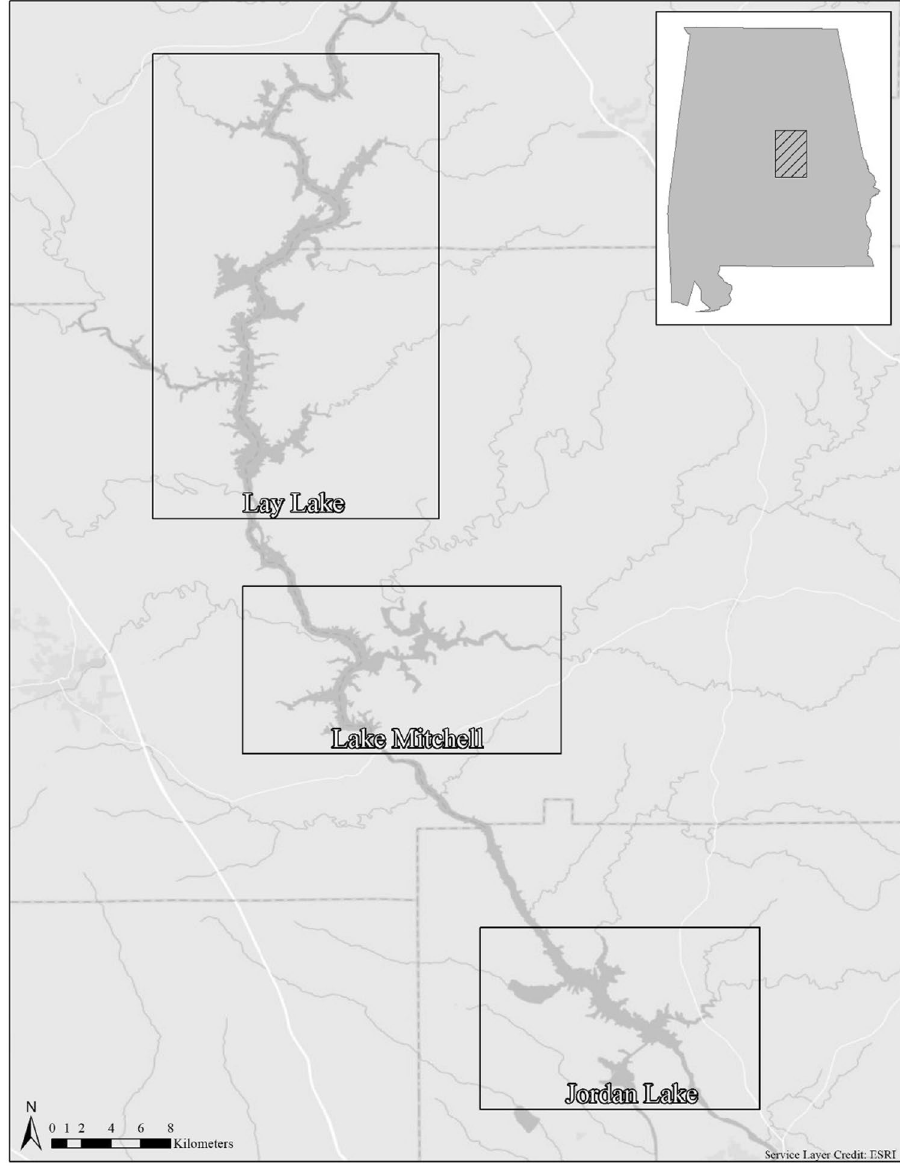
Fig. 1 Map and location of the three central Alabama reservoirs evaluated in this